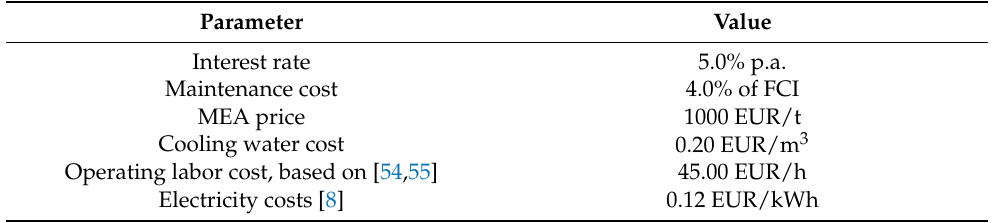
Table 5. Assumptions for cost calculations of CO 2 absorption plant. All parameters are based on [49], unless indicated otherwise. Parameter Value Interest